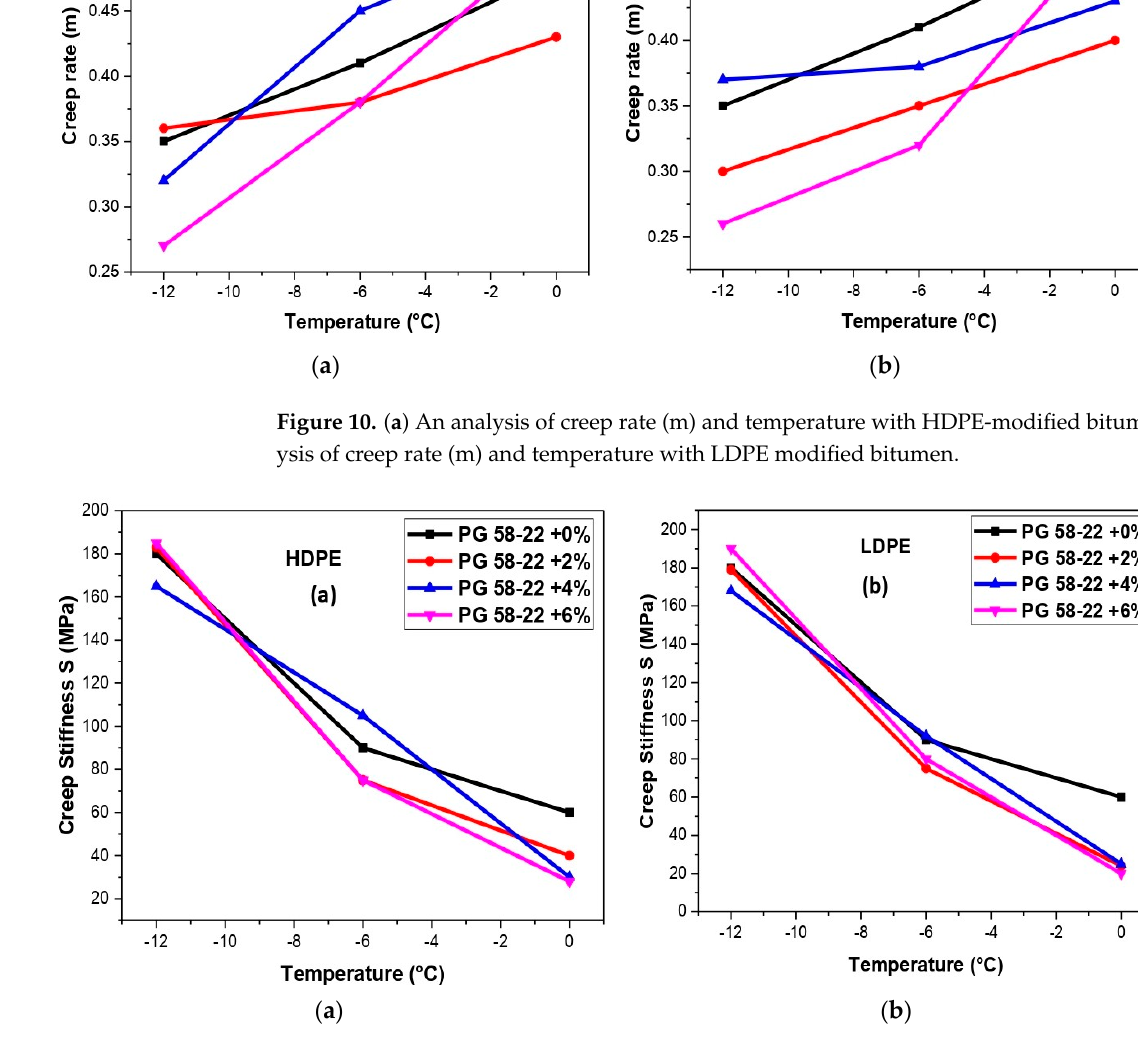
Figure 11. ( a ) An analysis of creep stiffness (S) and temperature with HDPE-modified bitumen, ( b ) analysis of creep stiffness (S) and temperature with LDPE-modified